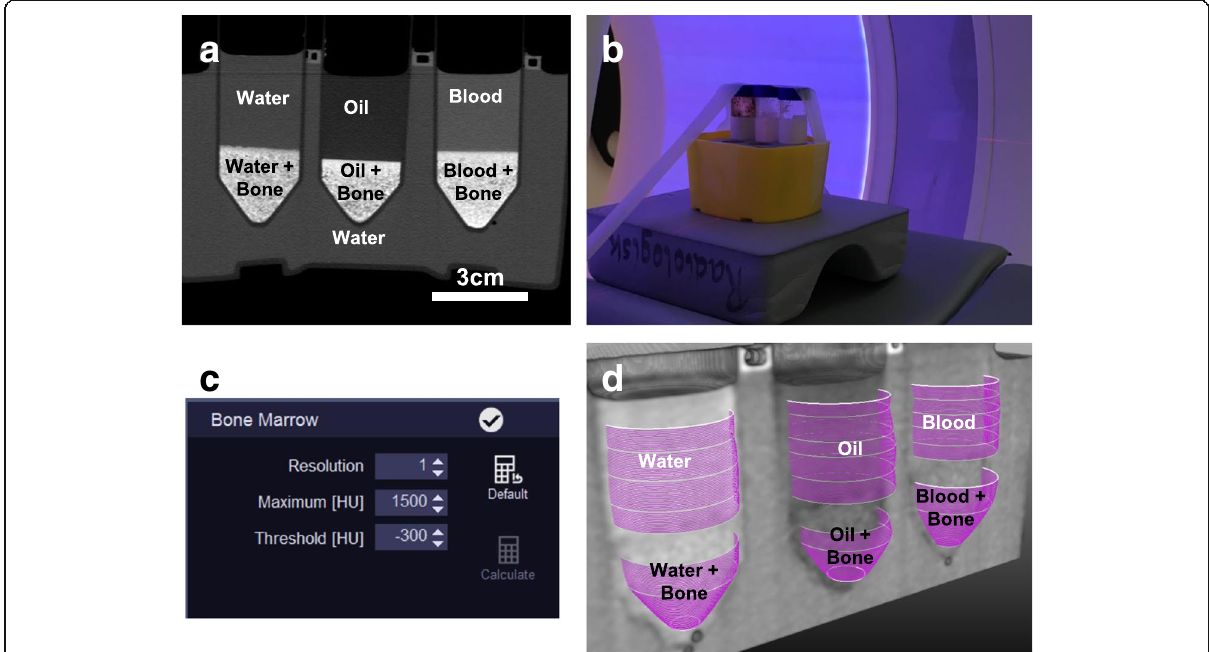
Fig. 1 Bone marrow phantom for dual-energy CT scanners. a Reformat of an ultra-high-resolution CT scan of three tubes filled with water, oil (as yellow marrow analogue/YMA) and blood (as red marrow analogue/RMA) and partially filled with bone granulate. Note that the granulate was more densely packed in the transition between fluid with bone and fluid without bone. This area was avoided in the analysis. b The phantom as placed in the CT scanner. c Settings used in the bone marrow oedema application class in Syngo.Via. d 3D rendering of the volumes of interest measured, which gives six unique measurement compartments, three compartments of fluid with bone and three of fluid without